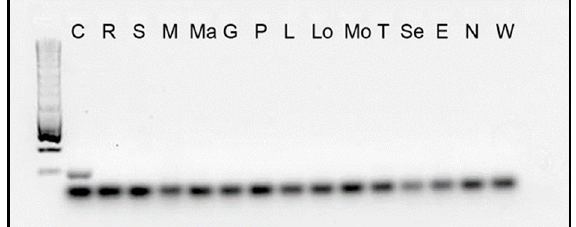
Figure 1. Electrophoresis in 1% agarose gels of cherimoya specific PCR reactions using the AChF2 and AChR2 primers (expected amplicon: 197 bp) and 14 DNA samples from different species in the Annonaceae family used as templates. (C) A. cherimola ; Che1, (R) A. reticulata ; Ret1, (S) A. squamosa ; Squ2, (M) A. muricata ; Mur2, (Ma) A. macroprophyllata ; Mac2 (G) A. glabra ; Gla1, (P) A. purpurea ; Pur1, (L) A. liebmanniana ; Lie1, (Lo) A. longiflora ; Lon1, (Mo) A. montana ; Mon1, (T) A. triloba ; Tri1, (Se) A. senegalensis ; Sen1, (E) A. emarginata ; Ema1, (N) A. neosalicifolia ; Neo1, (W) Water. Taxon codes are indicated in Table 1. Hiperladder 1 Kb of Bioline was used as size